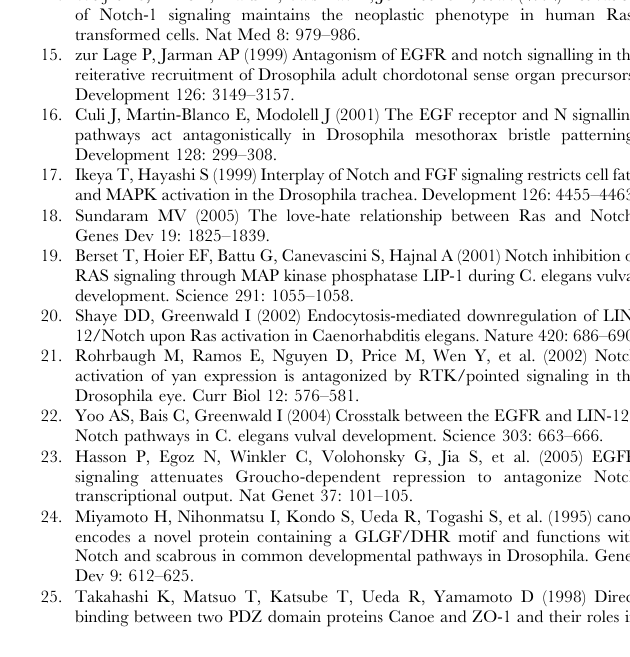
Figure S4 Dsh is required for MAPK activity. A 63 6 magnification of the dorsal mesoderm of three hemisegments is